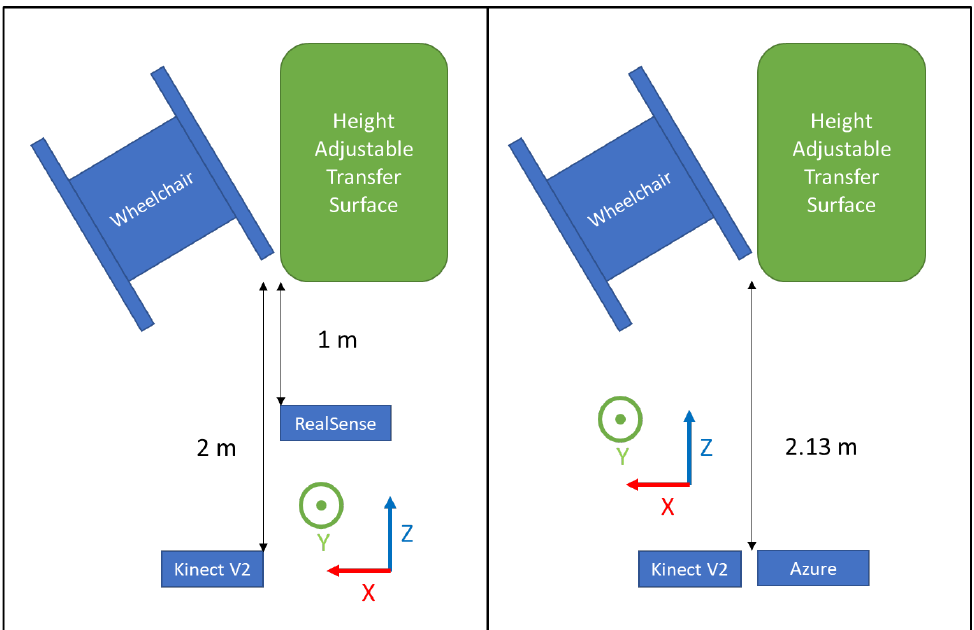
Figure 2. Experimental setup for Phase 1 ( left ) and Phase 2 ( right ).